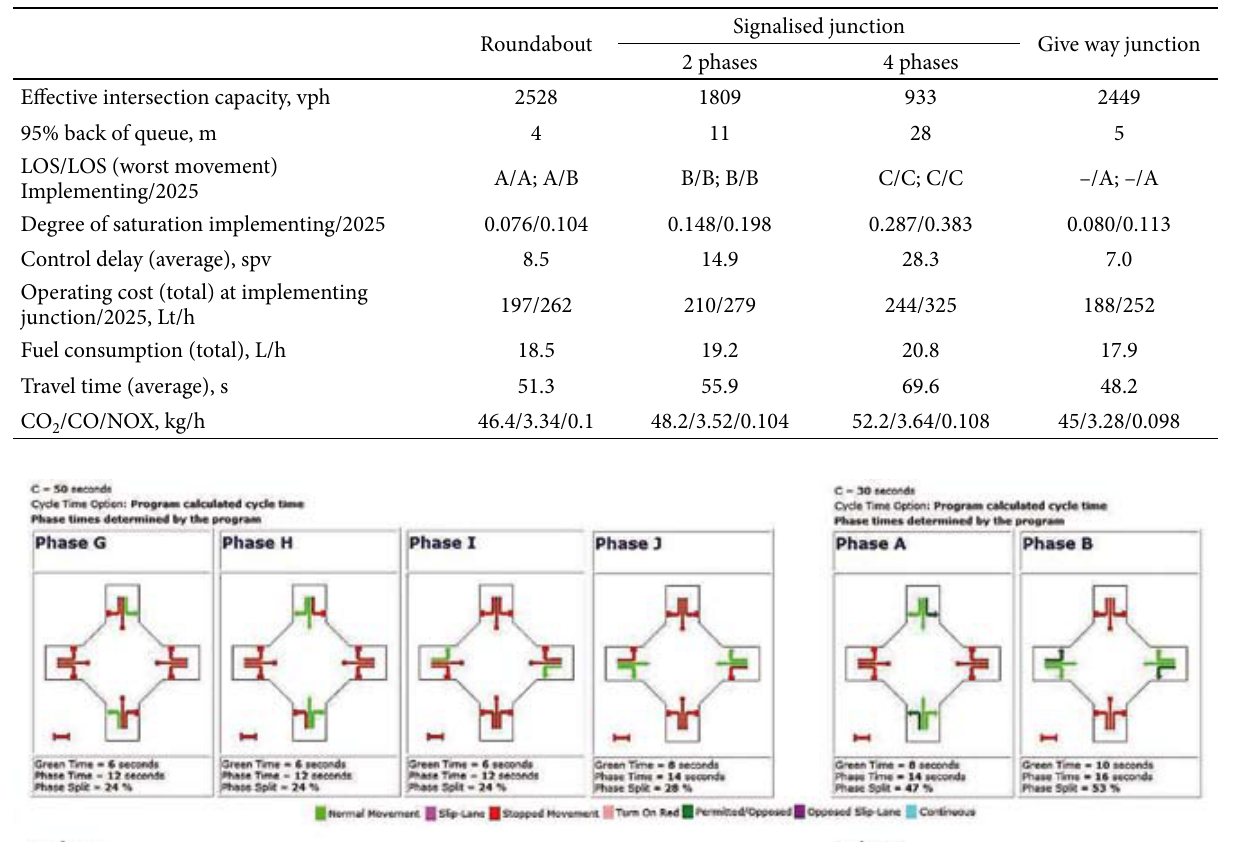
Table 3. SIDRA INTERSECTION outputs of the modelled junctions